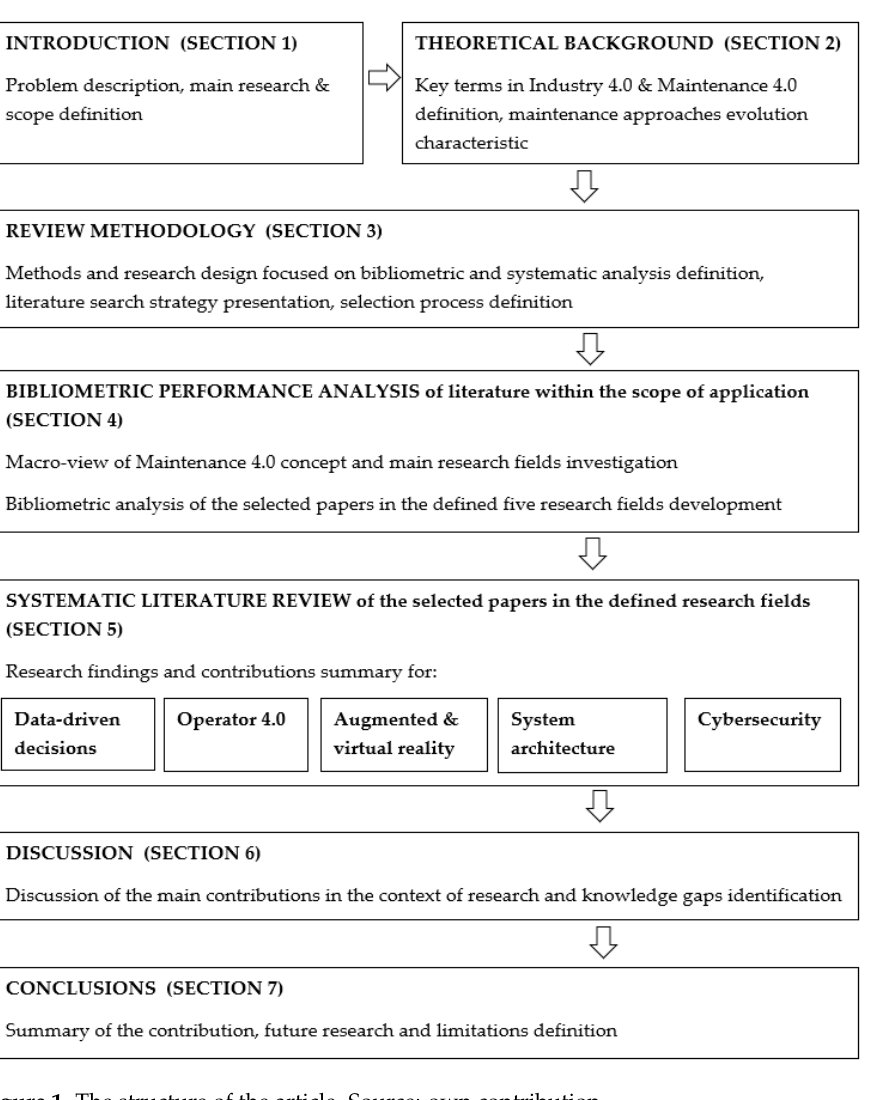
Figure 1. The structure of the article. Source: own contribution.